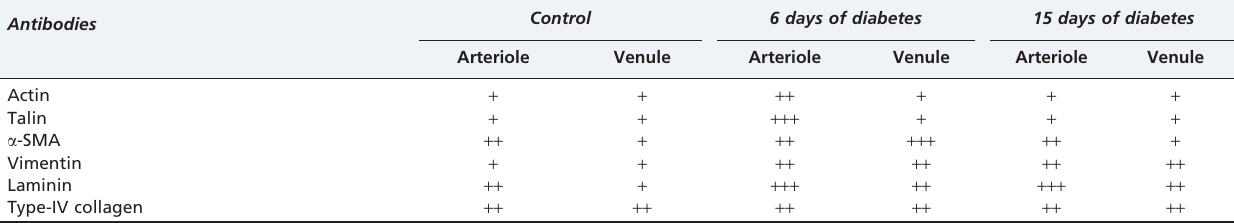
Table 2 - Distribution of actin, talin, a -SMA, vimentin, laminin, and type-IV collagen immunohistochemistry scores in age-matched control and 6- and 15-day diabetic